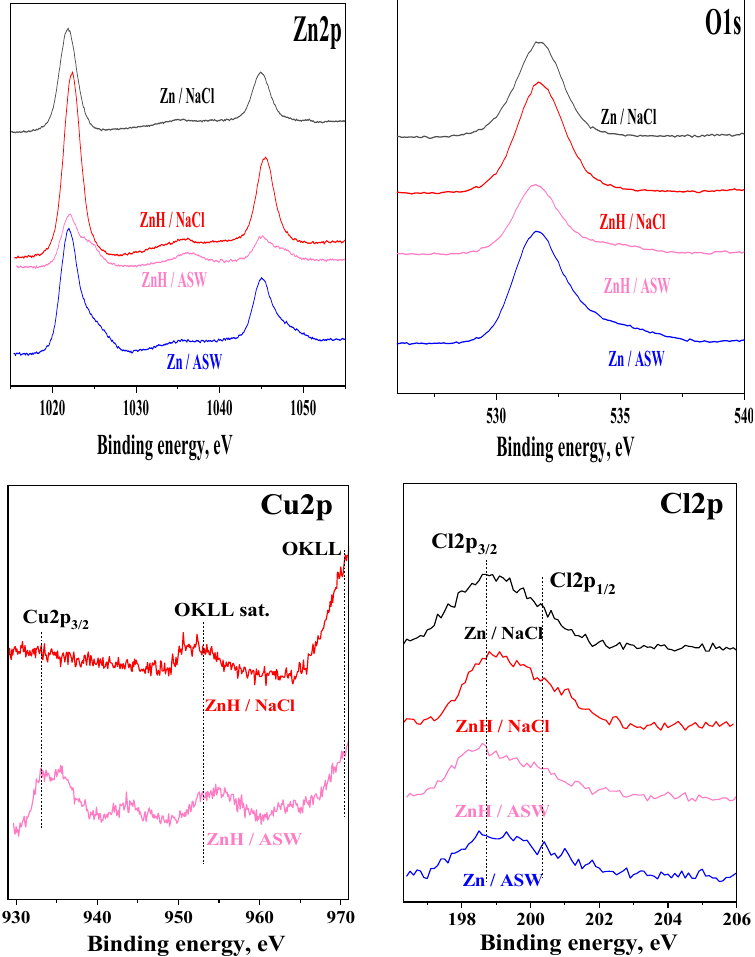
Figure 10. XPS spectra of the corrosive treated Zn and ZnH